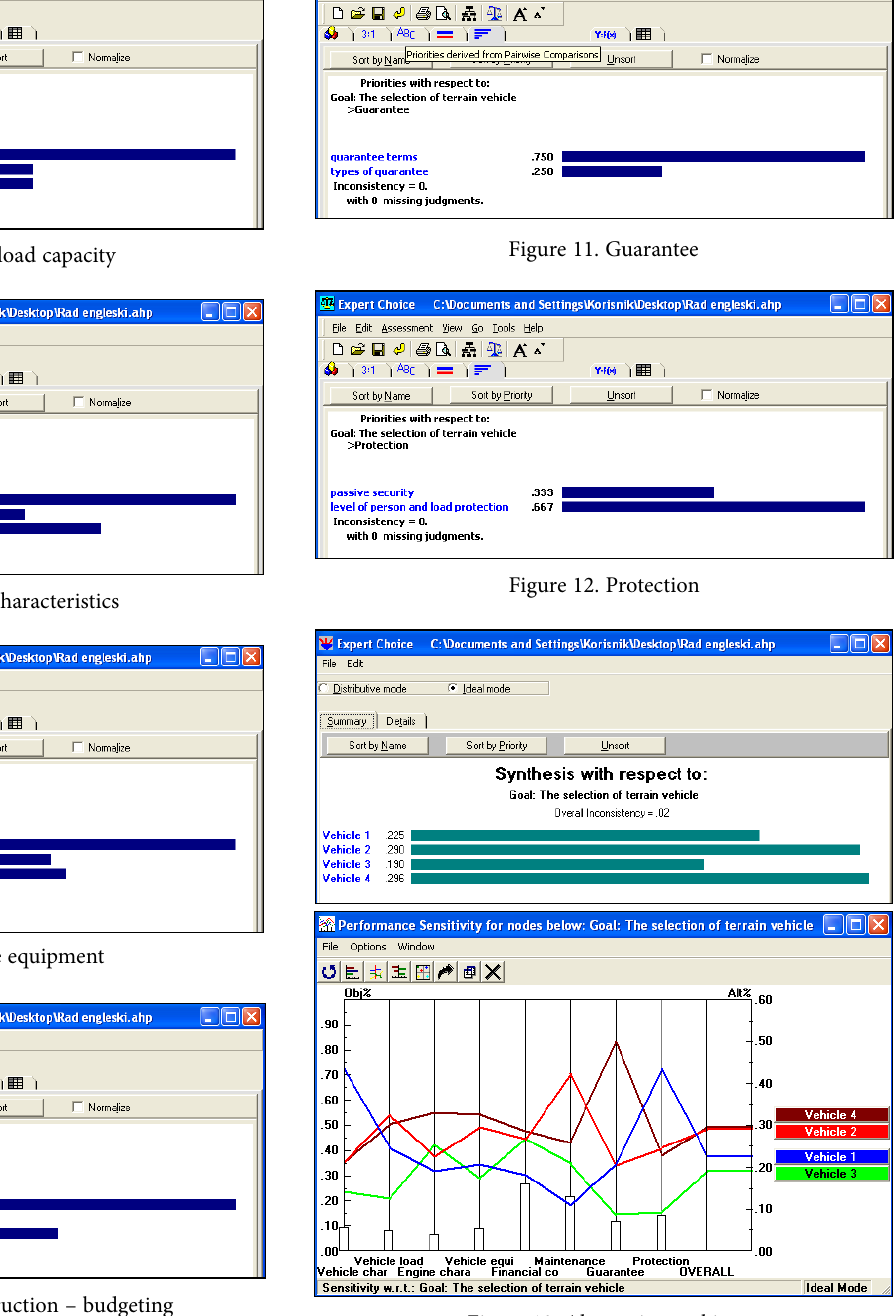
Figure 13. Alternative